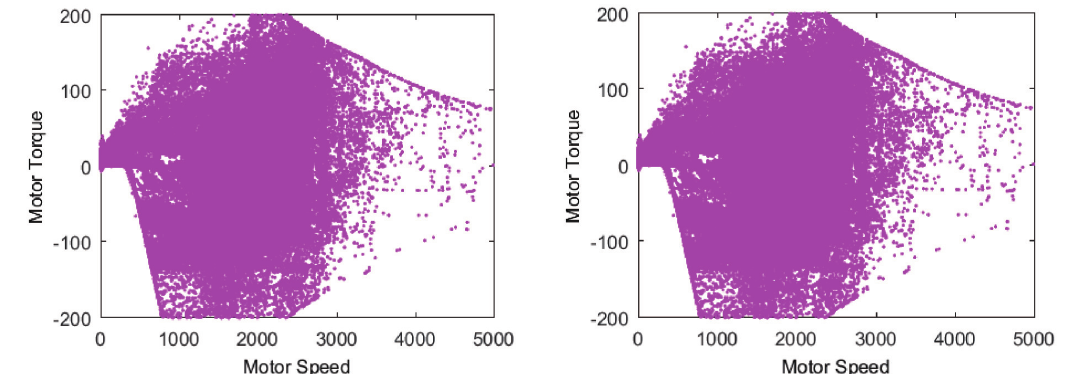
Figure 8. Motor operation points from the benchmark test ( left ) and the simulation ( right ).